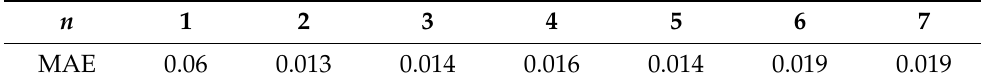
Table 6. MAE of Different Number of Past Moments n